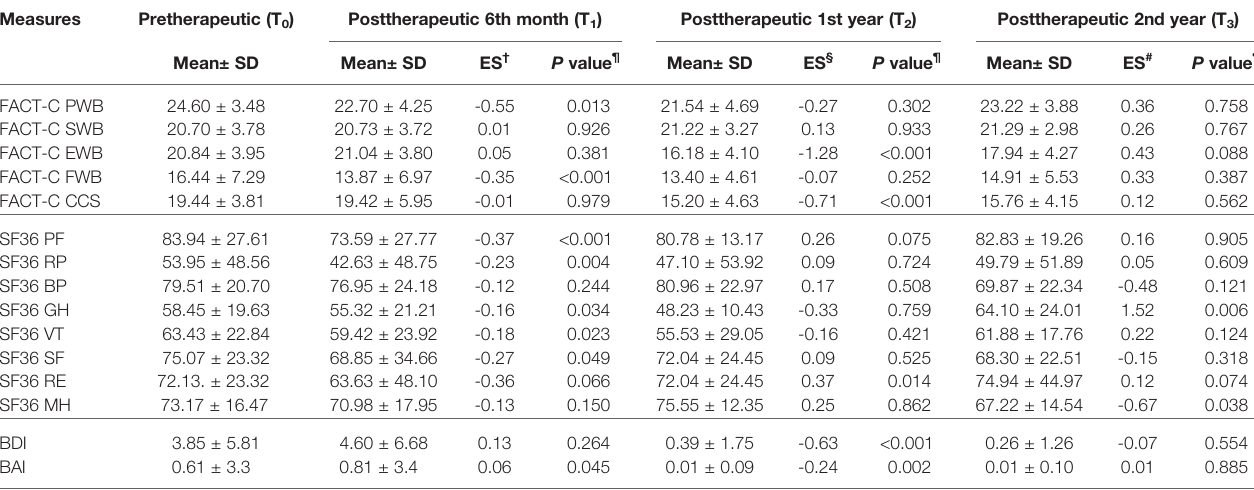
TABLE 3 | Paired t test was employed to evaluate trends of the FACT-C, BDI, BAI, and SF-36 in the control group in patients with metastatic colorectal cancer at different time points ( n =121). Measures